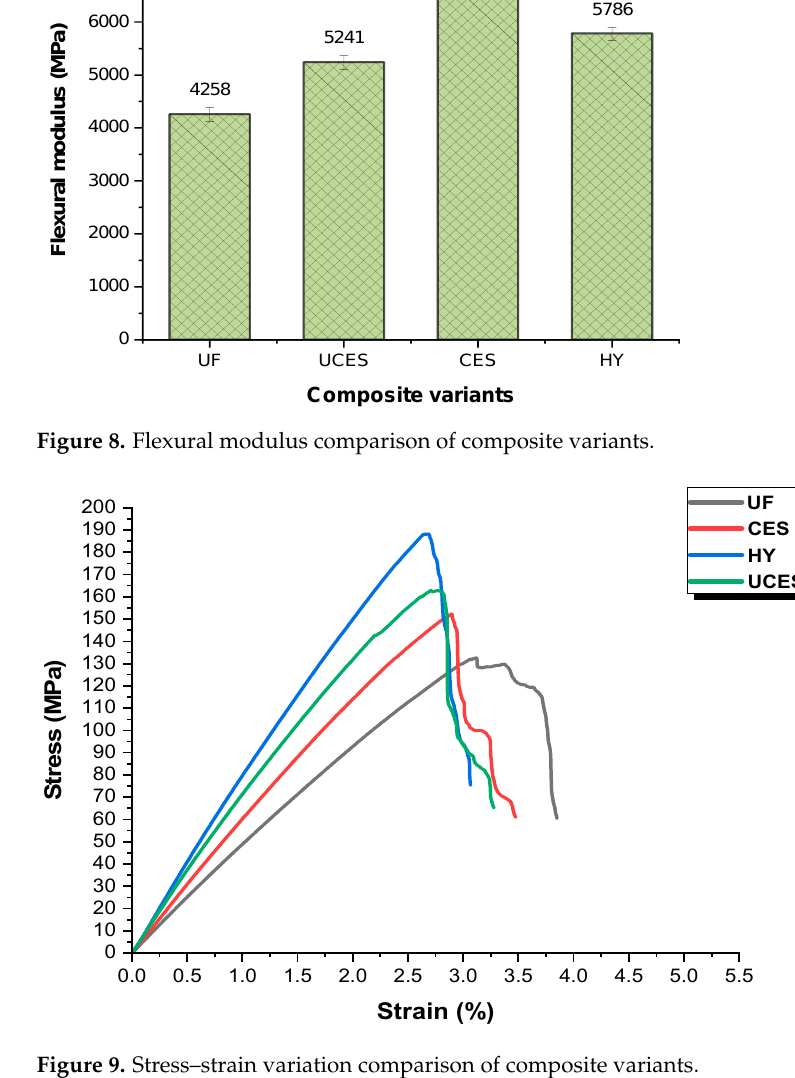
Figure 8. Flexural modulus comparison of composite variants.